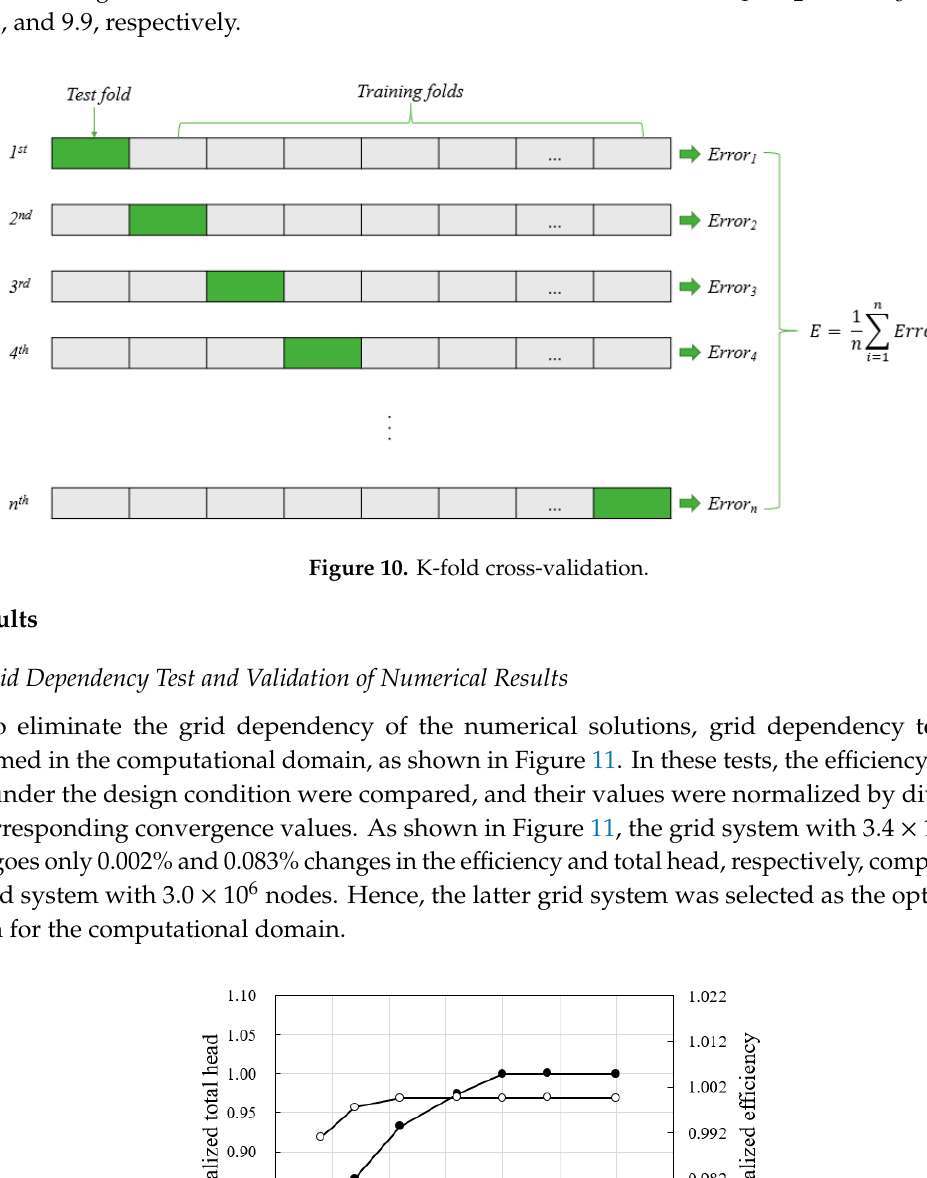
Figure 11. Grid dependency test.